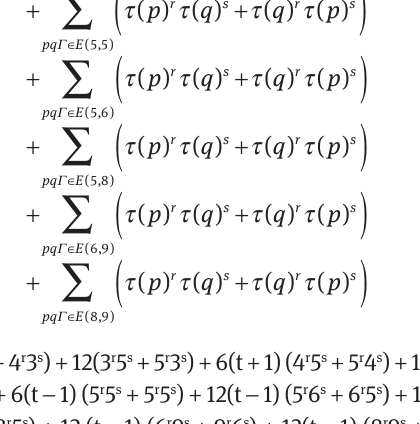
Table 9: Comparison among different Zagreb indices of MOF